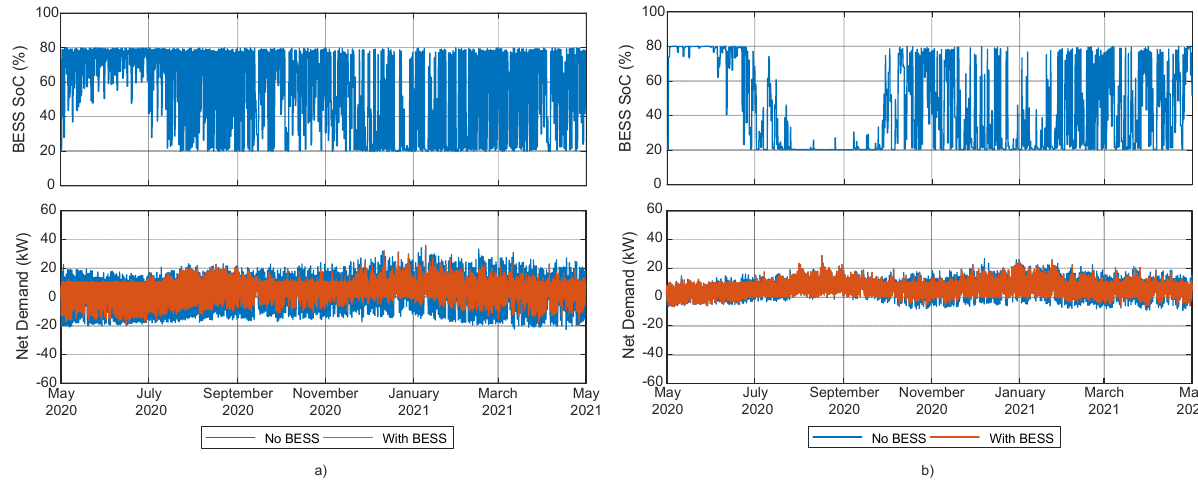
Figure 11. Net demand with and without storage and daily variations in the State of Charge. ( a ) EC4 with a 37 kWh BESS. ( b ) EC5 with a 10 kWh BESS.